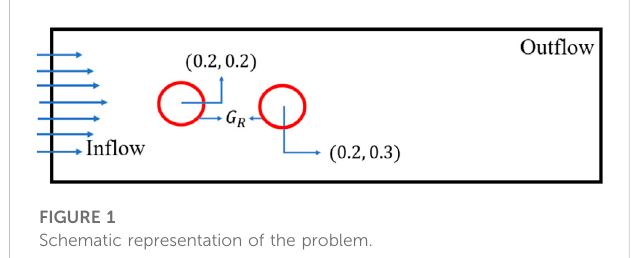
FIGURE 1 Schematic representation of the problem.